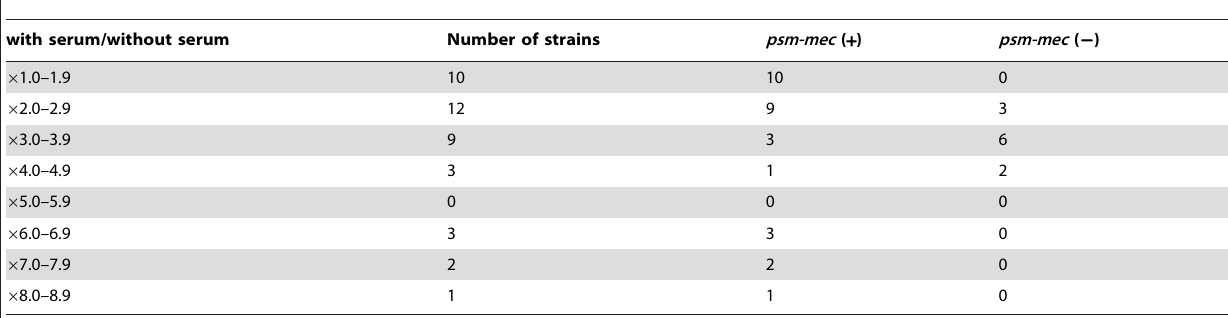
Table 1. Colony-spreading responses of MRSA strains to calf serum.